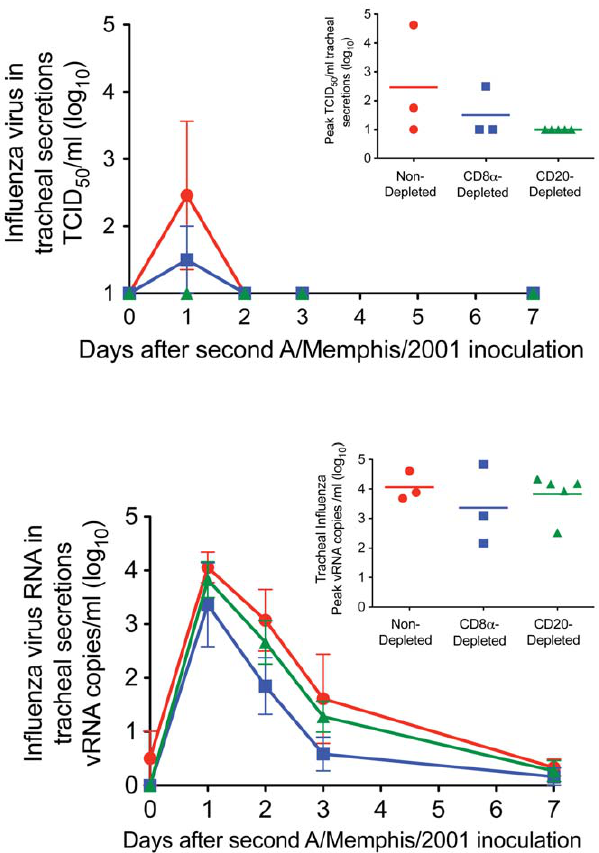
Figure 3. Influenza virus replication in the lower respiratory tract after A/Memphis/7/01 inoculation. A) Mean infectious virus titer in tracheal secretions (TCID 50 /ml). Inset; mean tracheal secretion N peak TCID 50 (B) Mean vRNA copy number in tracheal secretions (Log 10 copies/ml). Inset; mean tracheal secretion peak vRNA. No lymphocyte depletion before re-challenge (n=3) & CD8 a + T cell and NK cell depletion before re-challenge (n=3) m CD20 + B cell depletion before re-challenge (n=3).